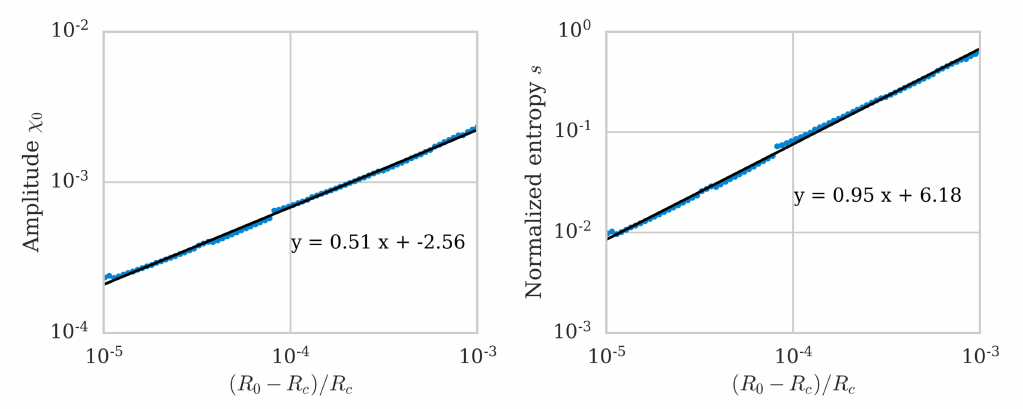
Figure 6 . Loglog plots of the amplitude χ 0 (left) and the normalized entropy (right), close to the critical temperature R as a function of ( R ) /R . The numerical results (in blue) are for the c 0 − R c c d = 3 heterotic string and l ads /l s = 600 . In black, we draw a linear fit of the results. The same power-law exponent was found for other values of l as well. ads